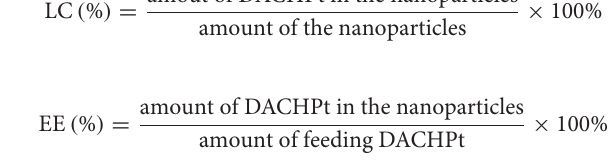
Frontiers in Pharmacology |